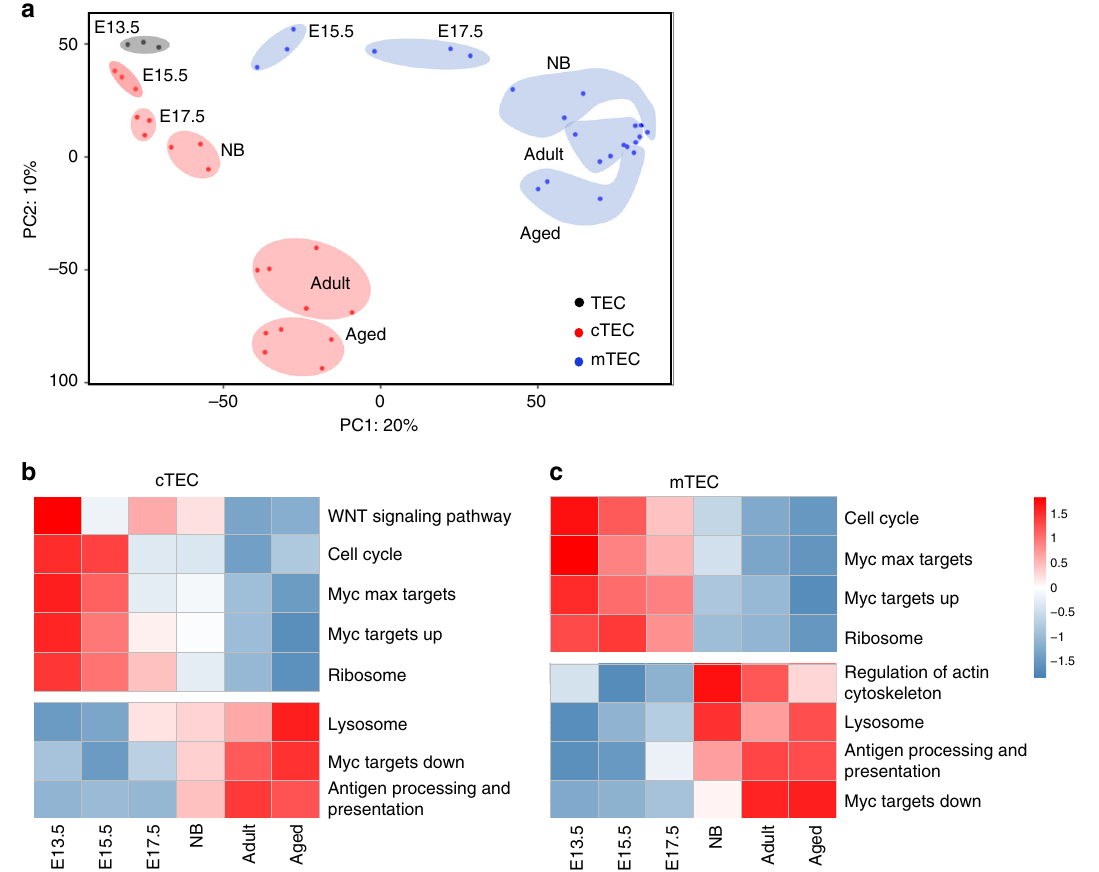
Fig. 1 Transcriptional diversity of TEC through development. Total TEC (CD45 − EpCAM + ) from embryonic day 13.5 (E13.5, black circles), or cTEC (CD45 − EpCAM + Ly51 + UEA − ) (red circles) and mTEC (CD45 − EpCAM + Ly51 − UEA + ) (blue circles) from mice at the indicated ages (E15.5, E17.5, newborn (NB), adult or aged were cell sorted for bulk RNA-seq analysis. a Two-dimensional representation of populations via a principle component analysis, where each data point is an individual sample and the shaded ovals identify replicate populations. b , c A row normalized heatmap of expression of gene pathways highly enriched in embryonic or adult cTEC ( b ) or mTEC ( c ) samples at indicated age, identi fi ed by gene set variation